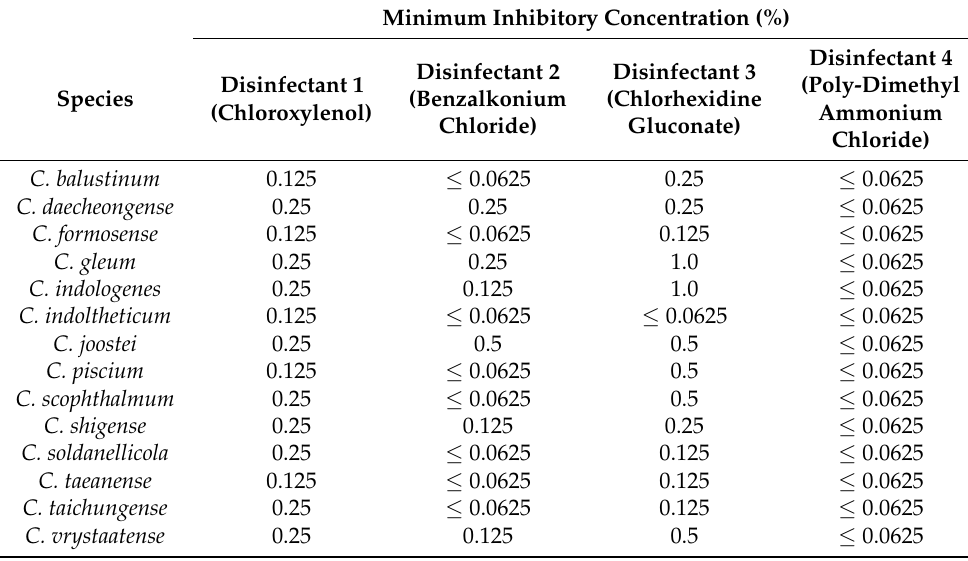
Table 5. Minimum inhibitory concentration (MIC) percentages of the four disinfectants against the 14 Chryseobacterium species evaluated in this